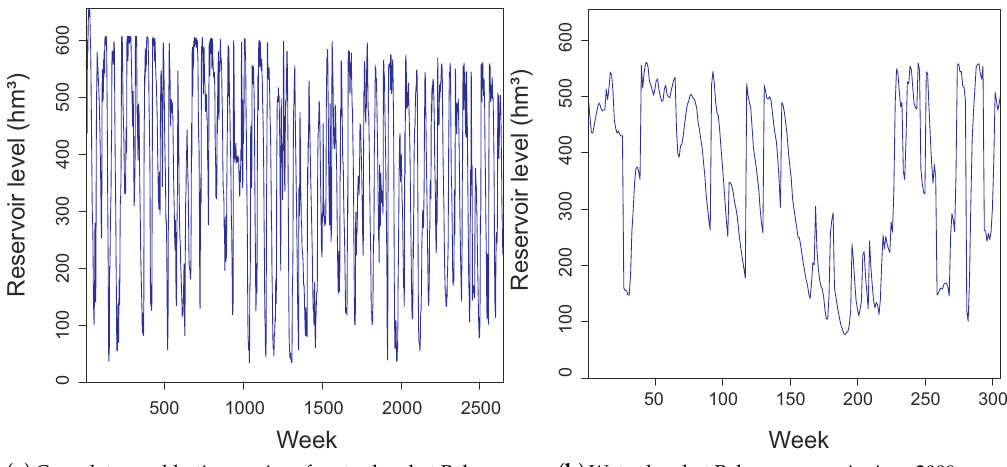
Figure 2. Time series of weekly water level at Belesar reservoir: ( a ) complete time series (since 1964); and ( b ) time series since 2009, when data from upstream measuring stations are